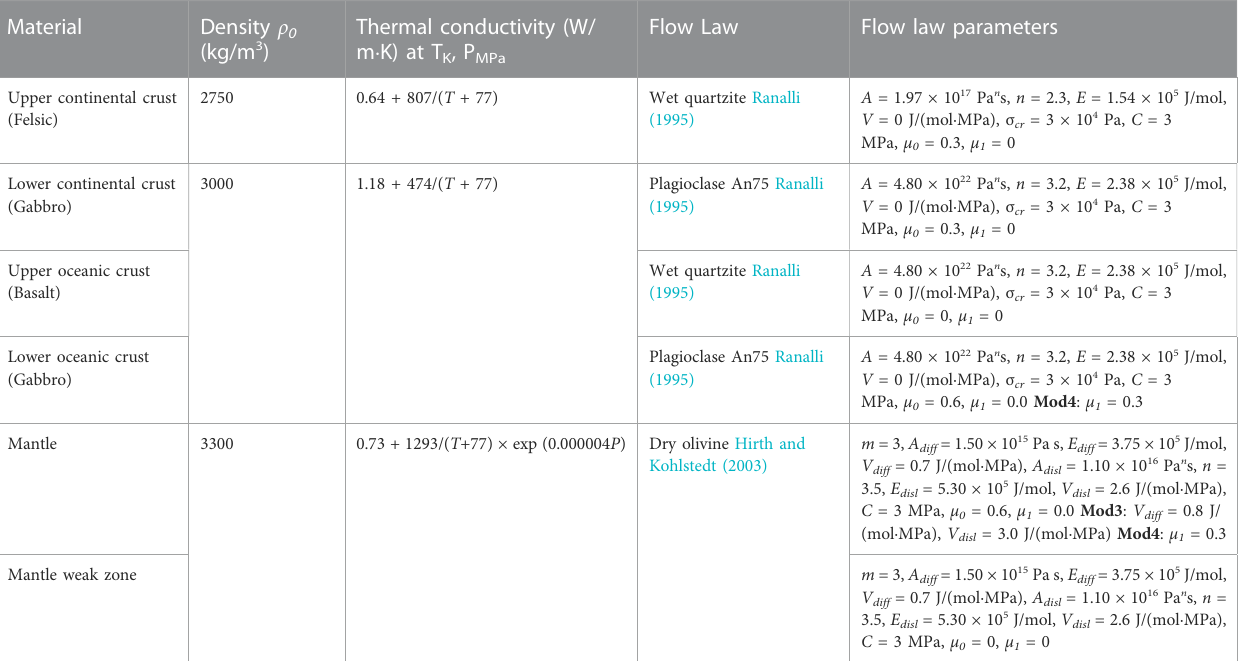
TABLE 1 Material properties used in the numerical experiments. The fl ow law include: A is the pre-exponential factor; E denotes activation energy; V is activation volume; n is the stress exponent; m is grain size exponent; σ cr is critical stress or the assumed diffusion-dislocation transition stress; C is the rock compressive strength at p =0 MPa; μ 0 and μ 1 are the initial and fi nal internal coef fi cients, respectively parameters (Karato and Wu, 1993; Ranalli, 1995; Hirth and Kohlstedt, 2003; Turcotte and Schubert, 2014). The subscripts “ diff ” and “ disl ” indicate that those parameters are associated with diffusion and dislocation creep processes, respectively. Mod3 has higher values for mantle activation volume than other models. Mod4 has higher fi nal internal friction coef fi cient for lower oceanic crust and the mantle. Other properties for all rock types include: heat capacity C p = 1000 J/(kg · K), thermal expansion α = 2 × 10 − 5 1/K; and compressibility β = 6 × 10 − 12